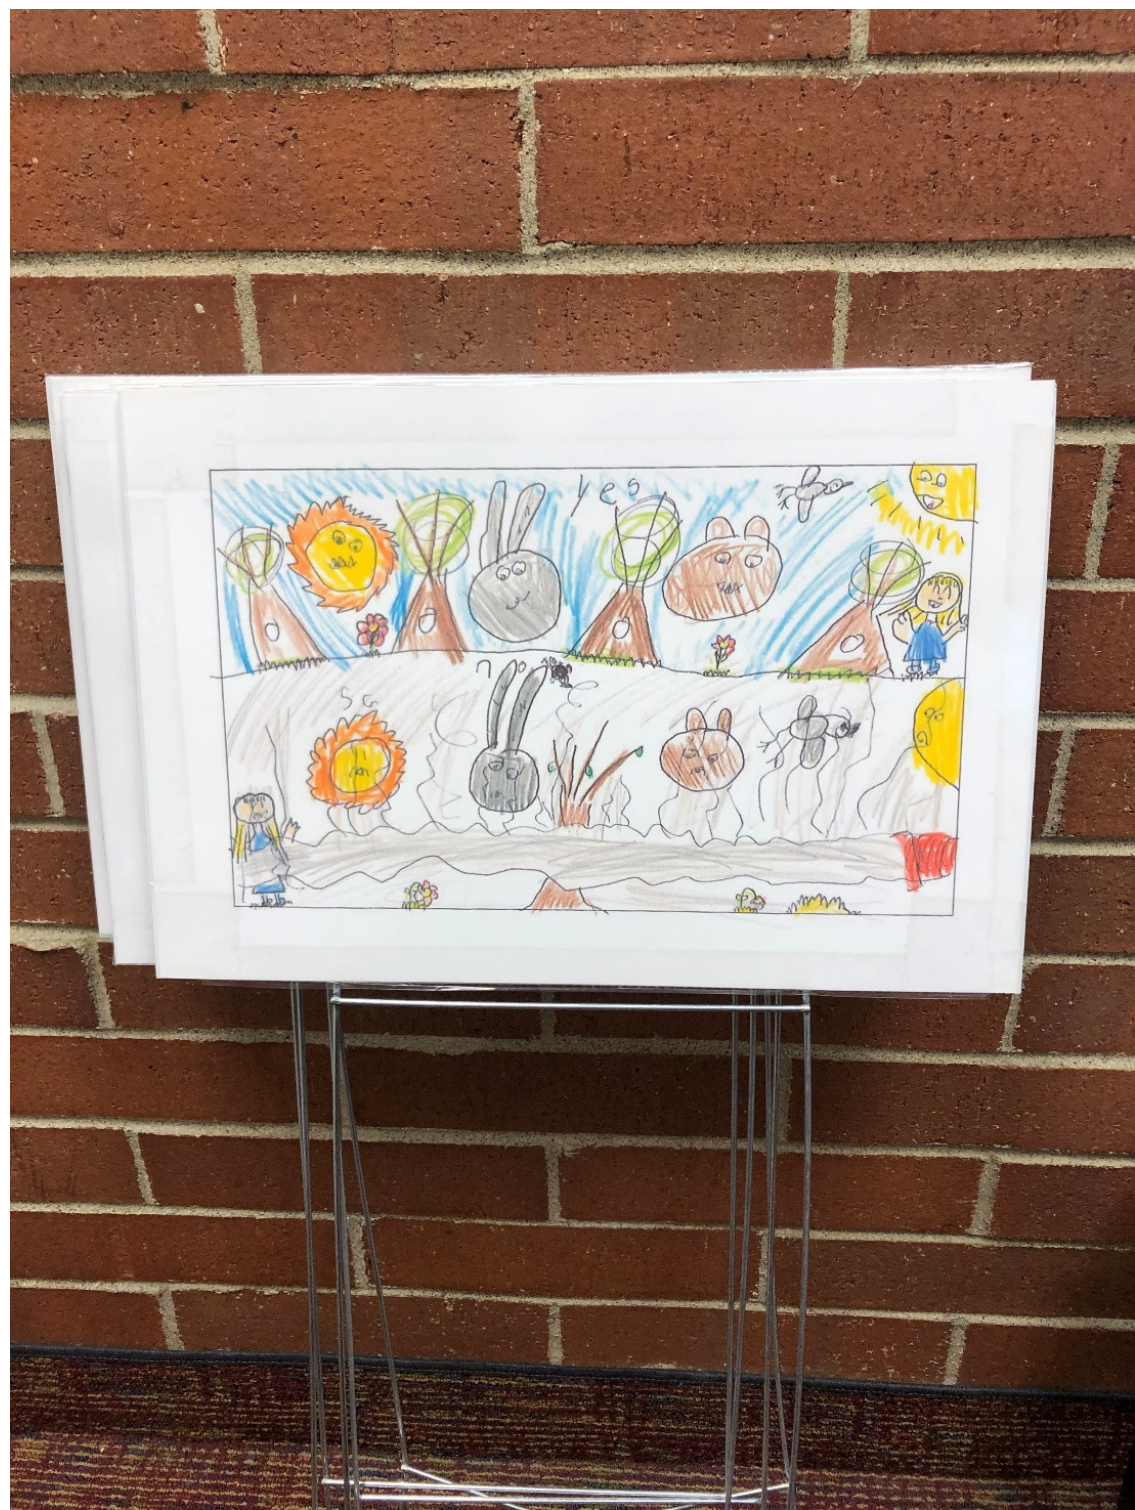
Figure A17. Student art display at school foyer.